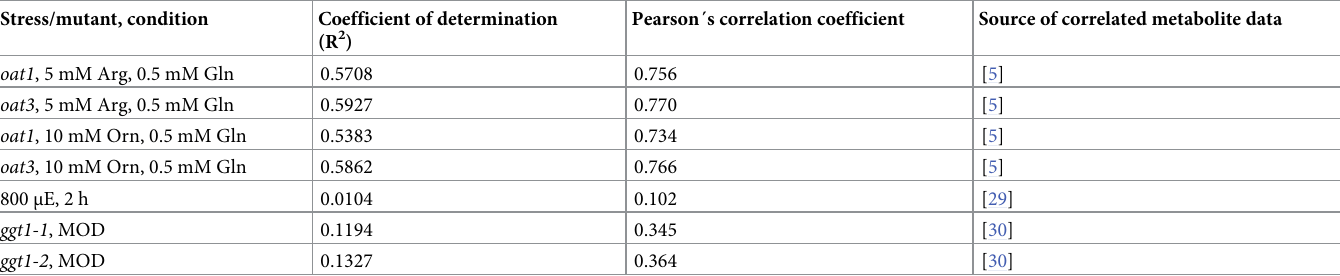
Visualization of correlation is given in S2 File. oat : T-DNA insertion in the gene encoding Arabidopsis ornithine- δ -aminotransferase, Arg: arginine, Gln: glutamine, Orn: ornithine, h: hours, ggt1 : T-DNA insertion in the gene encoding Arabidopsis glutamate:glyoxylate aminotransferase 1, MOD: middle of the